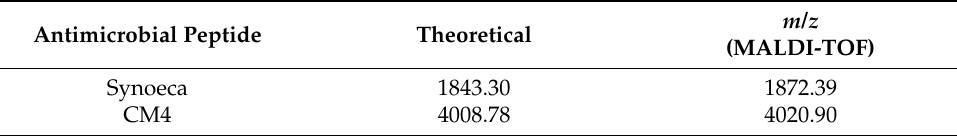
Figure 4. SDS-PAGE of AMP purification by ( A ) inverse transition cycling (ITC) and ( B ) size-exclusion chromatography (SEC) using desalting columns. Purification by ITC (Synoeca used as representative sample) demonstrates the presence of both A200 and AMP in the purified ELR fraction indicating loss of efficiency. Purification by SEC resulted in improved purification efficiency, resulting in high recovery and highly pure ( B ) Synoeca (MW = 1.84 kDa) and ( C ) CM4 (MW = 4.01 kDa) fractions. Gels were stained with silver nitrate. MWM—molecular weight marker (KDa). Table 1. Theoretical (Expasy ProtParam; https://web.expasy.org/protparam/, accessed on 30 October 2020) and experimentally determined (MALDI-TOF) molecular weights (in Da) for pure isolated Synoeca and CM4.